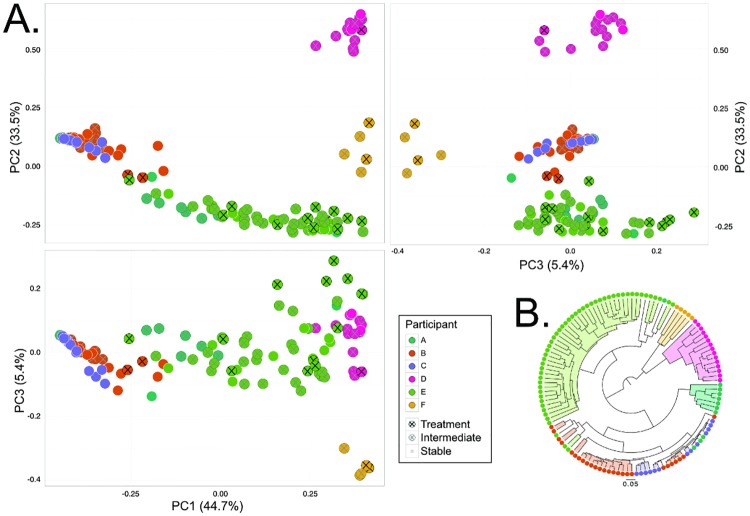
The CF lung microbiome is distinguished by individual.A. PCoA plots of all participants illustrate the clustering of participant samples, indicated as significant by PERMANOVA (p = 0.001). Health state within participants, as defined as Stable, Intermediate (<1 month pre- or post-Treatment), and Treatment was significant (PERMANOVA, p = 0.016), but was highly confounded by the participant (p = 0.042 of Participant:Health interaction term). B. UPGMA phylogeny depicting the Bray-Curtis dissimilarity between samples. It is apparent that the principle driver of similarity between samples are inter-individual microbial lung composition due to the almost complete separation of participant samples. PC = Principal Coordinate.